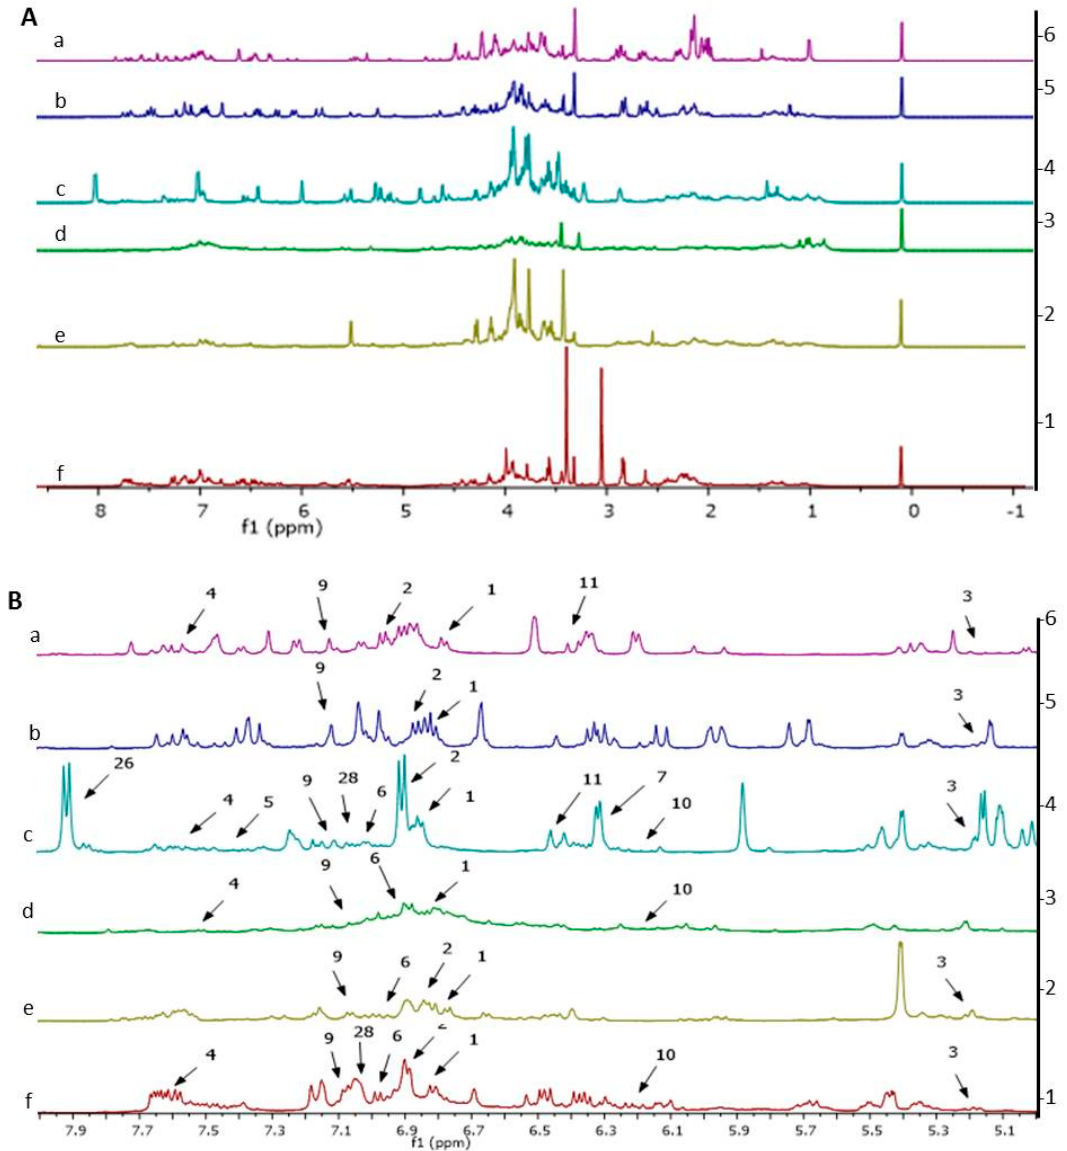
Figure 3. Full 1 H-NMR spectra of selected herbs ( A ) and expanded 1 H-NMR spectra of aromatic region from δ 5.5 to 9.0 ( B ). a: P. indica , b: C. longa , c: P. minus , d: V. negundo , e: O. javanica , f: C. caudatus . The